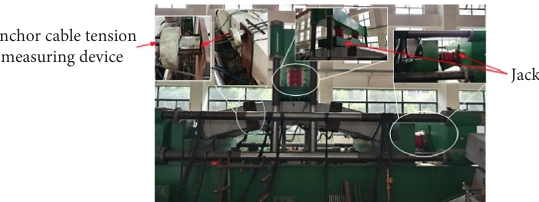
Figure 3: Segment loading test bench.